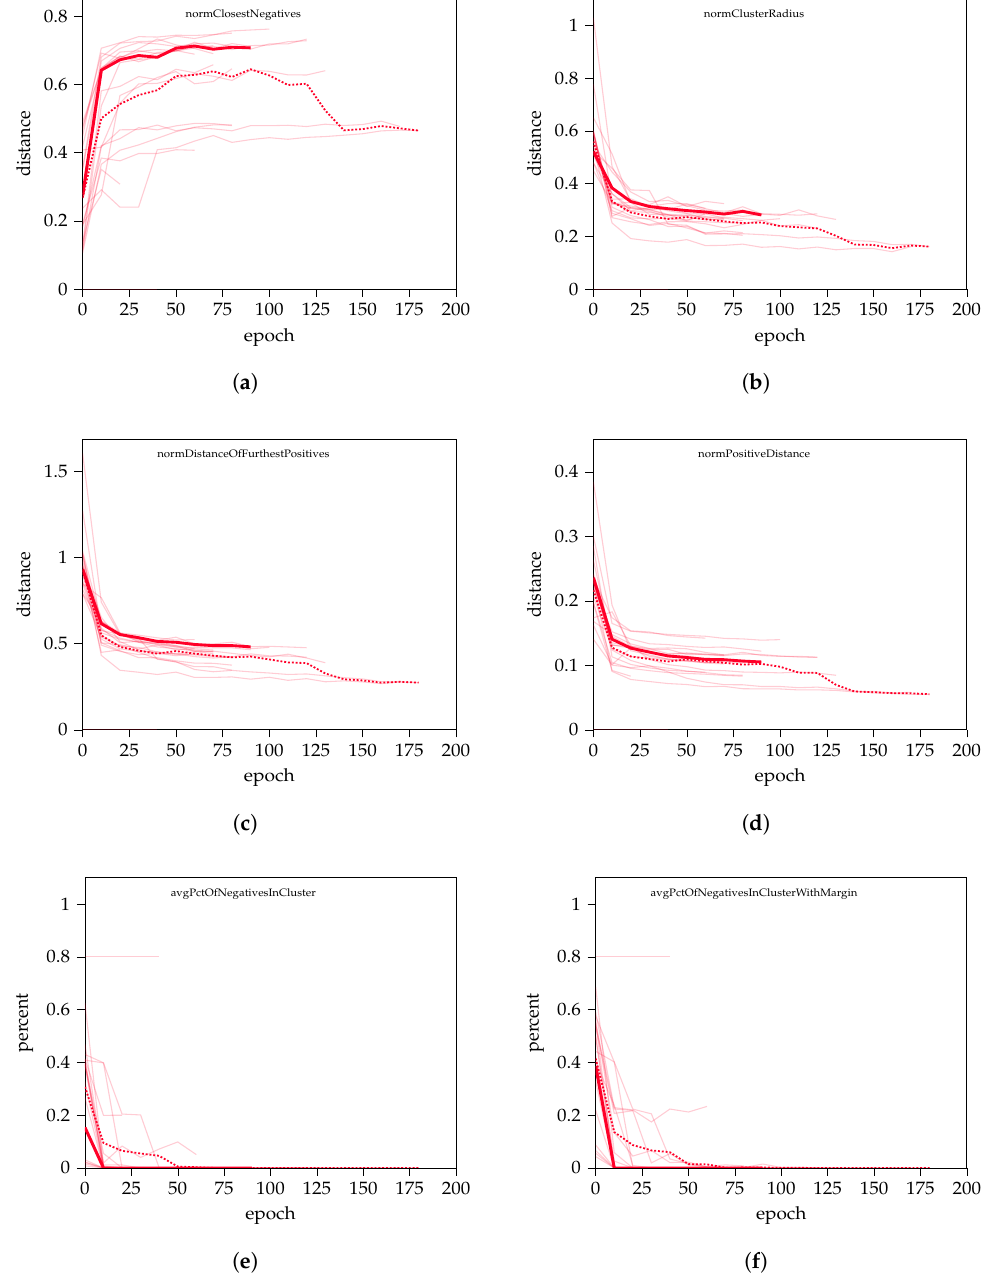
Figure A4. Cluster analysis results for the proposed NSPA method. Sub-figures show ( a ) the dynamic of the normalized closest negative distance, ( b ) cluster radius, ( c ) distance of furthest positive, ( d ) distance of all positives, and ( e , f ) the average percentage of non-positive pairs in clusters without and including margin,